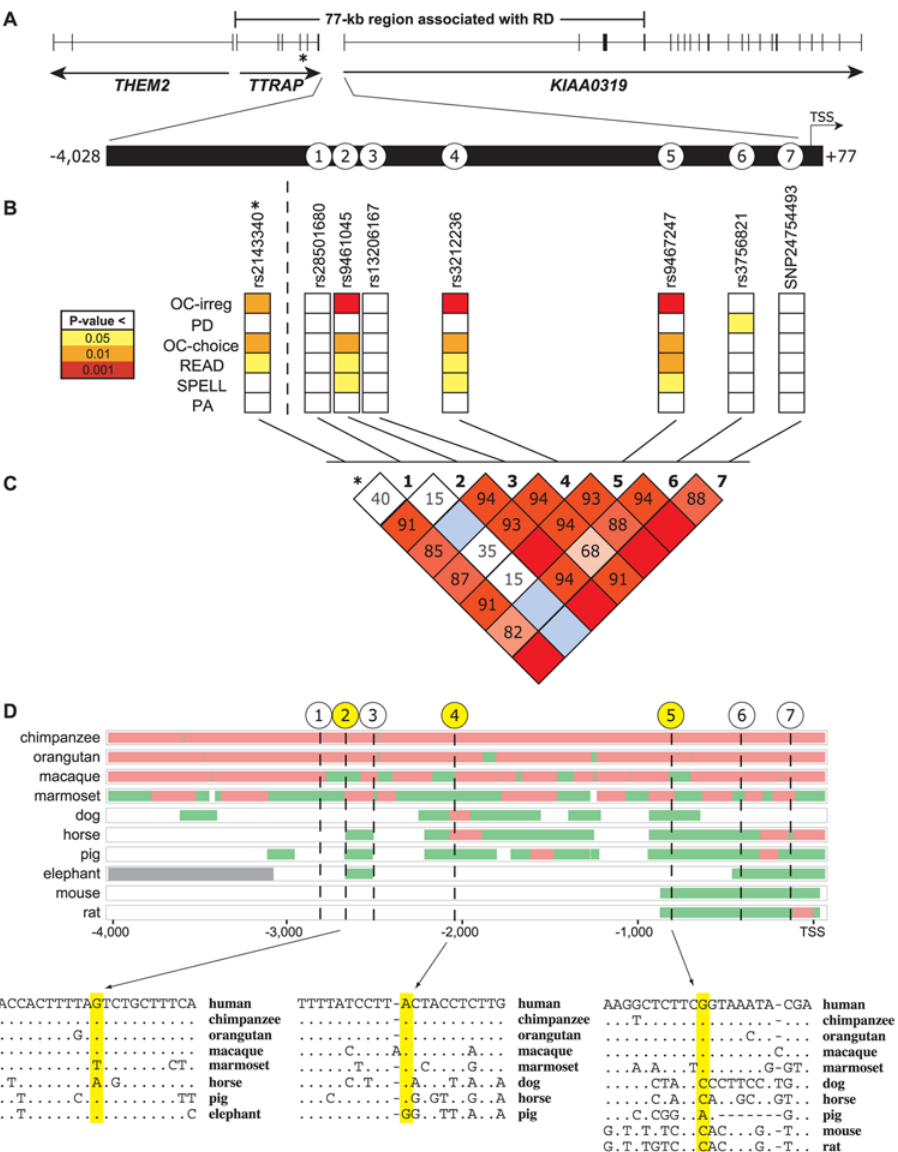
Figure 1. KIAA0319 promoter region SNPs residing on the RD-associated risk haplotype. (A) Graphical representation of the location of the seven SNPs (corresponding to SNPs 1–7) on the RD-associated risk haplotype within the genomic region 4,028 bp upstream and 77 bp downstream of the KIAA0319 TSS. The asterisk within TTRAP depicts the location of rs2143340, the risk haplotype-tagging SNP. (B) Associations of each SNP variant with the six indicated quantitative reading-related measures, as assessed by genotyping sample 1 (see Methods for details). (C) Representation of LD across the genomic region harboring these variants (calculated from the same genotyping data as in B), evaluated by Haploview version 4.0. The indicated numbers represent absolute D prime (D’) between two loci. An empty red box represents complete LD, while an empty blue box indicates low LD. (D) MultiPip (percent identity plot) alignment of genomic sequence from the indicated vertebrate species across the region containing SNPs 1–7 compared to the human sequence derived from the non-risk BAC. Red indicates . 75% identity between that species’ sequence and the human sequence over 100 nucleotides; green indicates . 50% identity between that species’ sequence and the human sequence over 100 nucleotides; grey corresponds to sequence missing in that species; white corresponds to no sequence from that species aligning with the human sequence for the indicated interval. At the bottom, the nucleotide-level alignments are provided for the immediate regions encompassing SNPs 2, 4, and 5 (with the position of the SNP highlighted in each case; note that the depicted human sequence reflects the non-risk haplotype). A dot indicates that the corresponding base in that species matches the base in the human reference sequence.